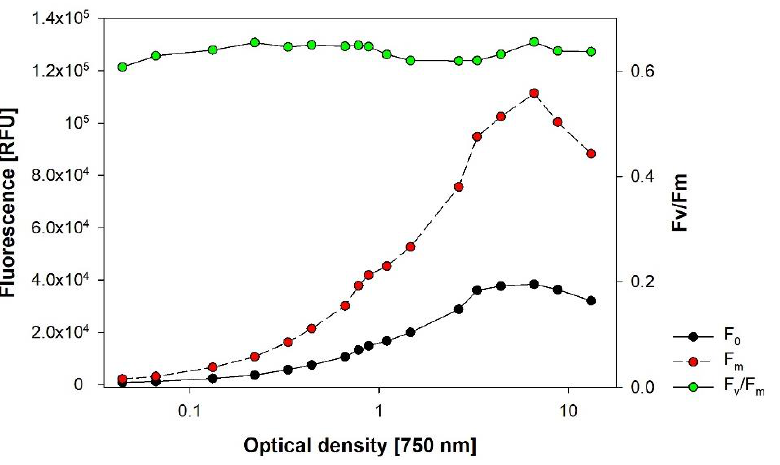
Figure 10. Dilution experiment with Chlorella vulgaris cultivated in BG11 full medium. The highest OD of about 13 corresponds to DM of 0.84 gL −1 . Readings were taken with the AquaPen AP100